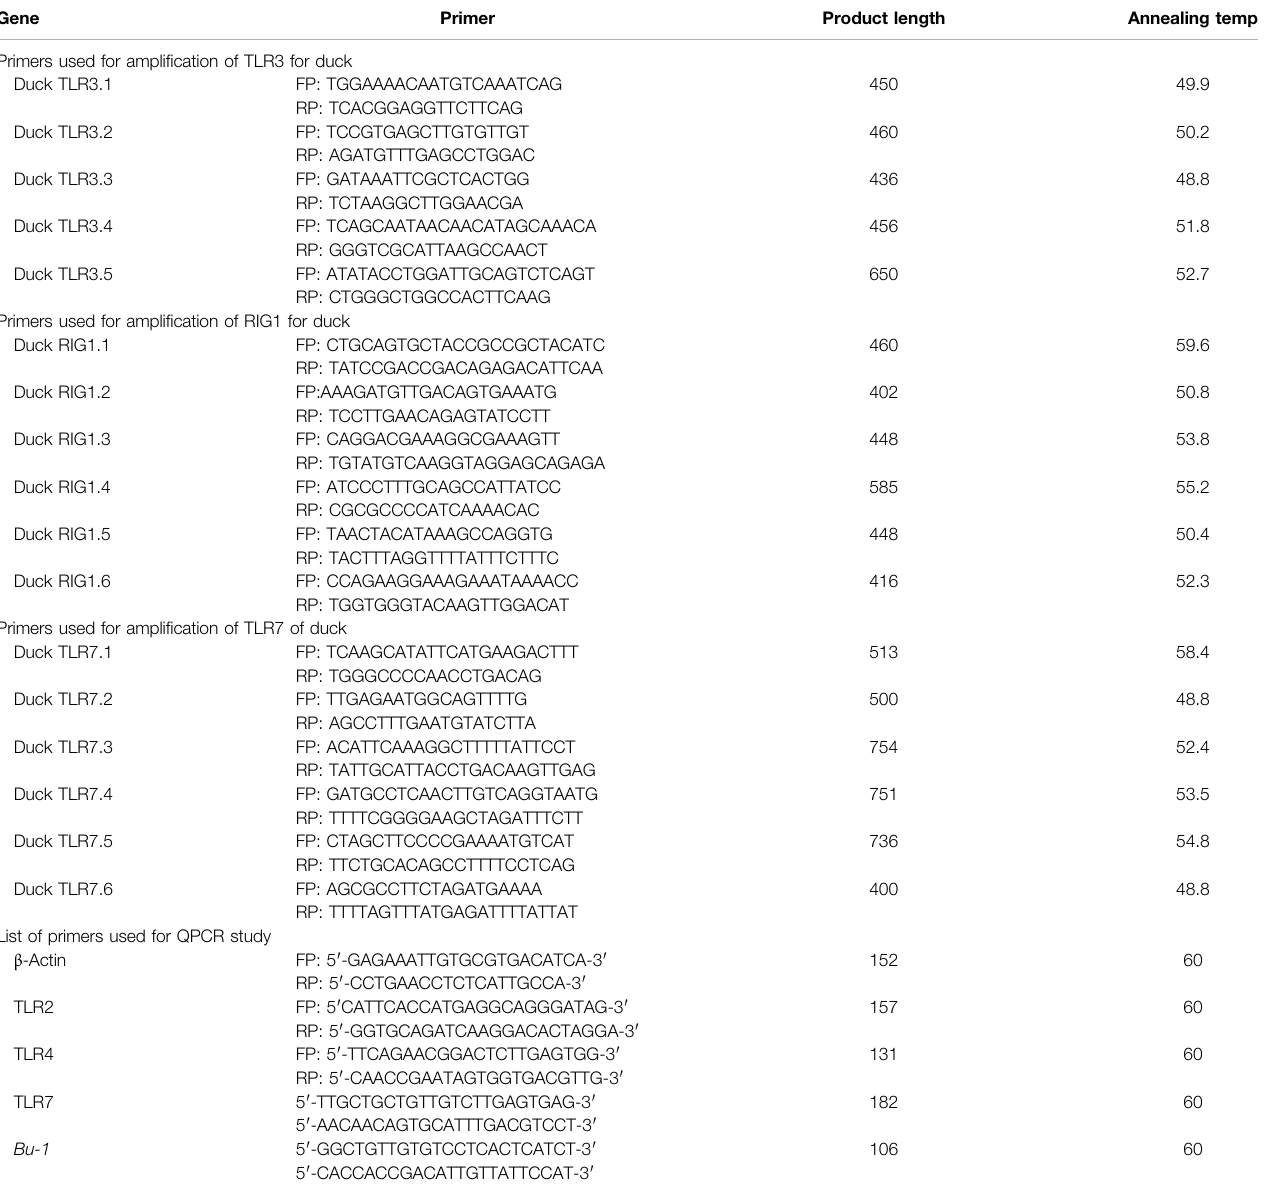
TABLE 1 | List of primers used for ampli fi cation of TLR3, RIG1, and TLR7 genes in indigenous duck. Gene Primer Product length Annealing temp Primers used for ampli fi cation of TLR3 for duck Duck